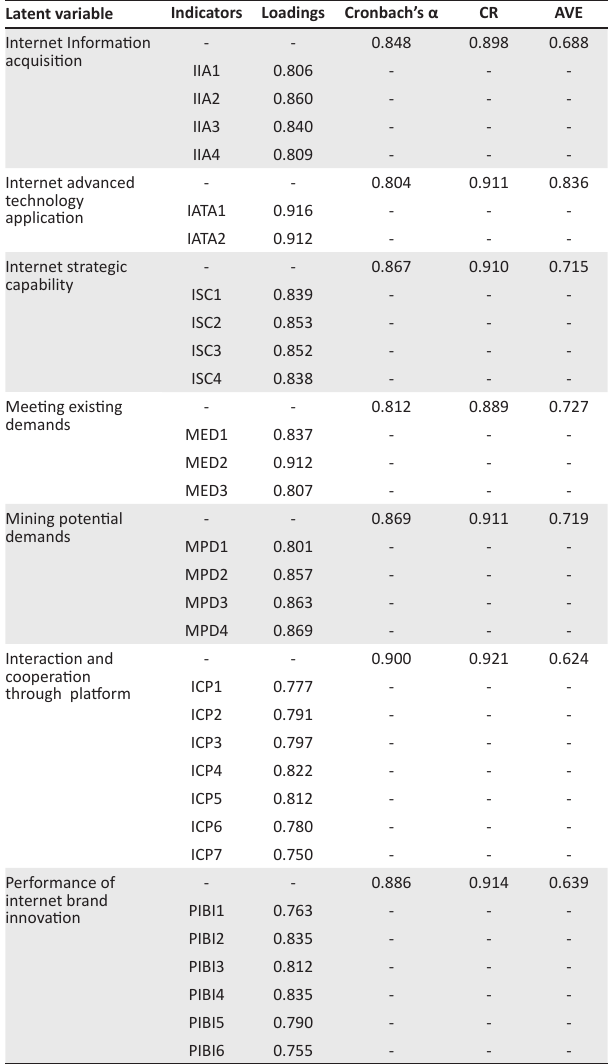
TABLE 4: Discriminant validity test. TABLE 3: Reliability and convergent validity